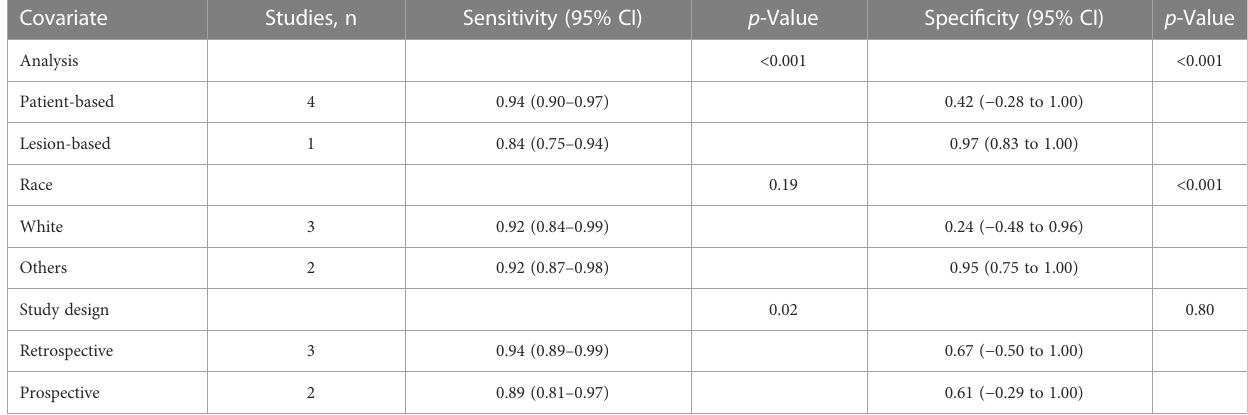
TABLE 3 Meta-regression analysis for 18 F-DCFPyL PET in detecting suspected prostate